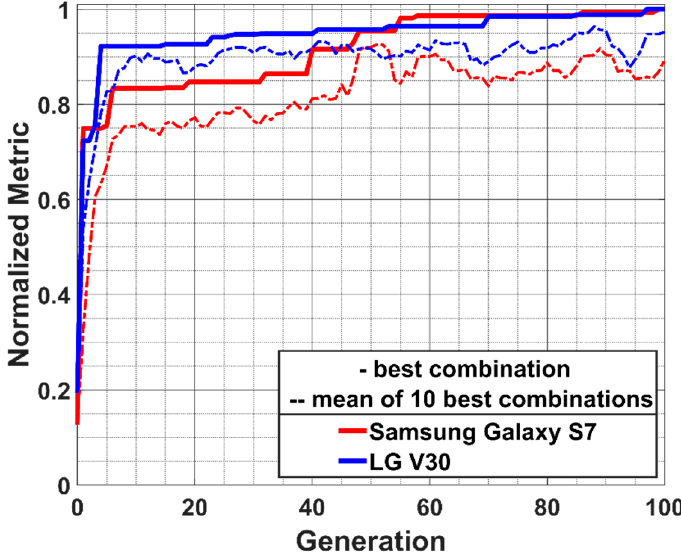
Figure 8. The optimization process of the normalized fitness values. The weights represent the walkway structure, BLE and WLAN fingerprinting, magnetic field anomalies, and step length estimation.